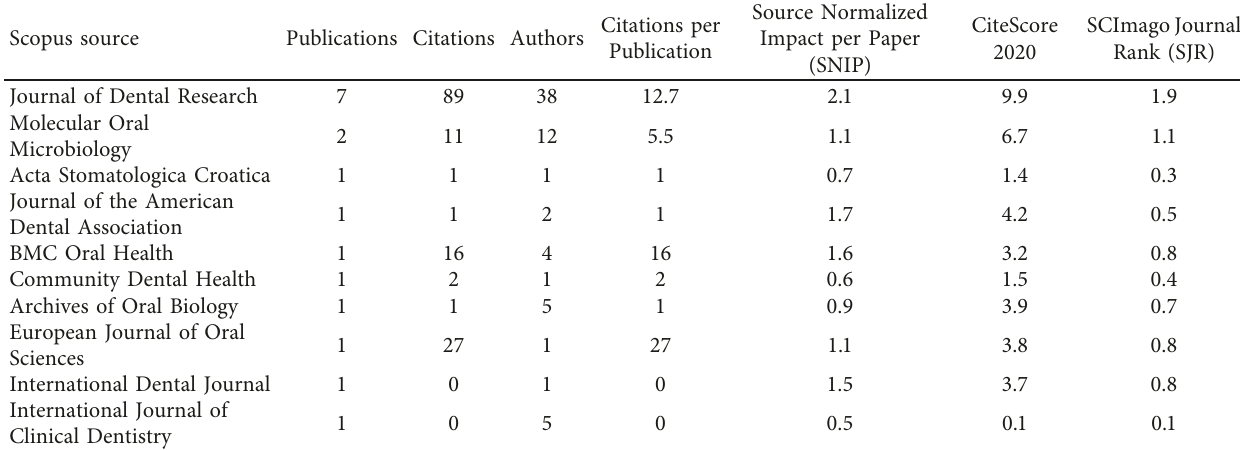
Table 3: Top 10 of all publication types of caries vaccine by Scopus source.